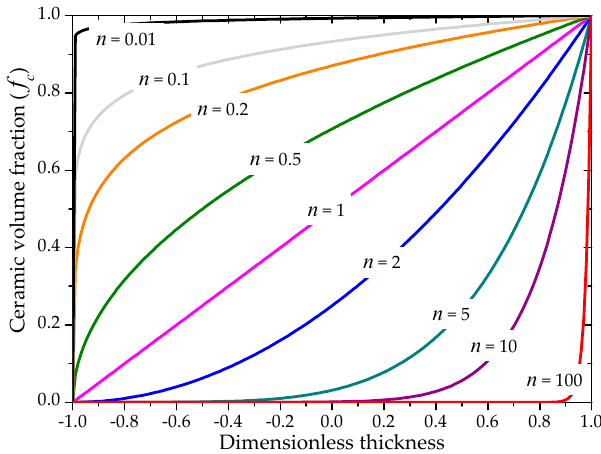
Figure 3. Schematic representation of the functionally graded thin plate. Materials 2018, 11, x FOR PEER REVIEW